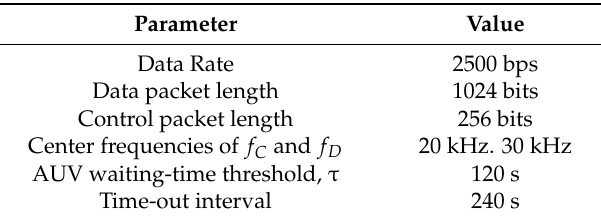
Table 1. Simulation Parameters.